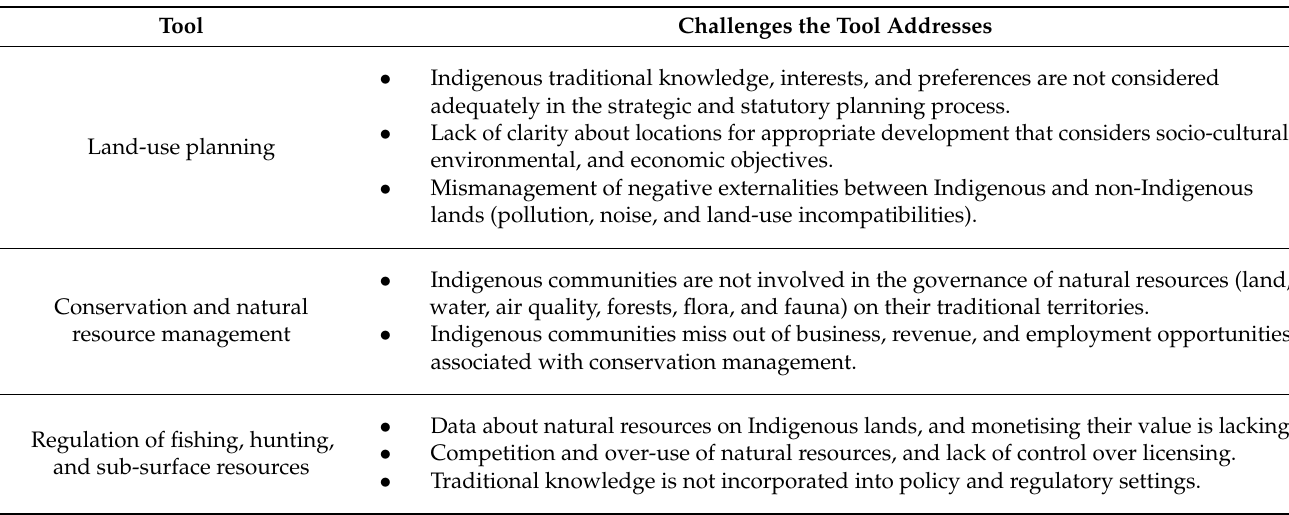
Table 2. Instruments to mobilise the development potential of Indigenous land.